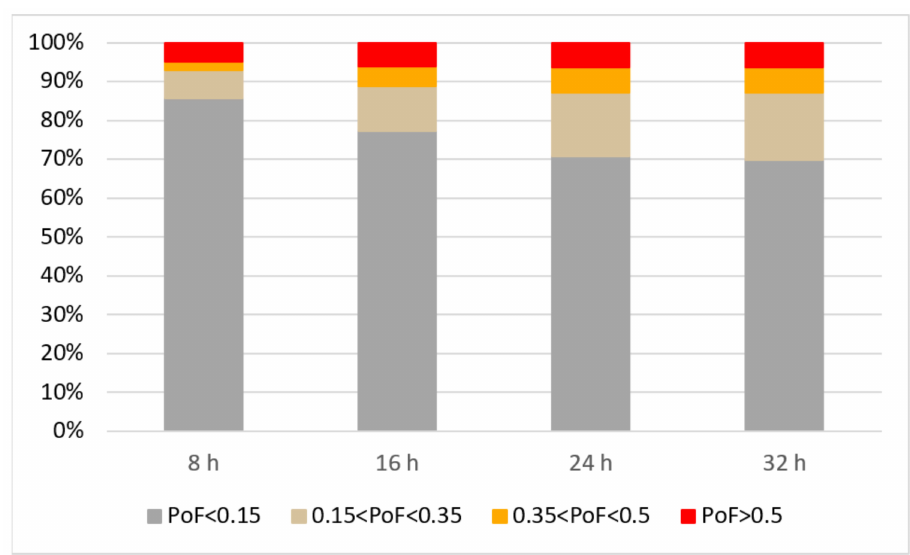
Figure 6. Number of cells in each PoF r class for different time instants td of the rainfall event.